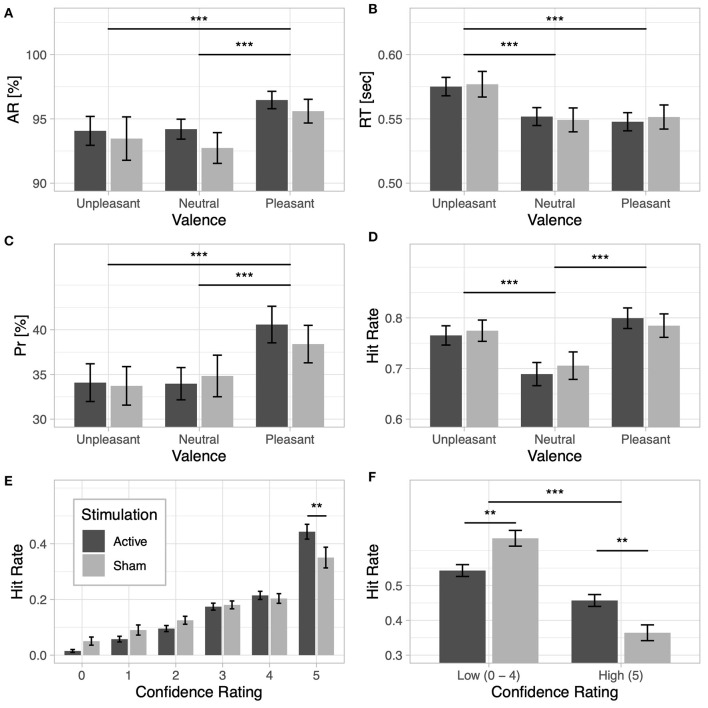
Lexical decision task: (A) accuracy rate (AR) and (B) response time (RT) for unpleasant, neutral, and pleasant words under the active and sham stimulation conditions. Recognition memory: (C) discrimination index (Pr) and (D) hit rate based on valence for the active and sham stimulation conditions. (E) Recognition confidence: hit rate based on confidence responses for the active and sham stimulation conditions. (F) Recognition memory based on confidence ratings: hit rate based on high-confidence category (words that received confidence ratings of 5) and low-confidence category (words that received confidence ratings from 0 to 4) for the active and sham stimulation conditions; note that the low-confidence hit rate category is the cumulative hit rate for ratings 0–4. Two asterisks indicate a p-value smaller than 0.01 and three asterisks indicate a p-value smaller than 0.001.